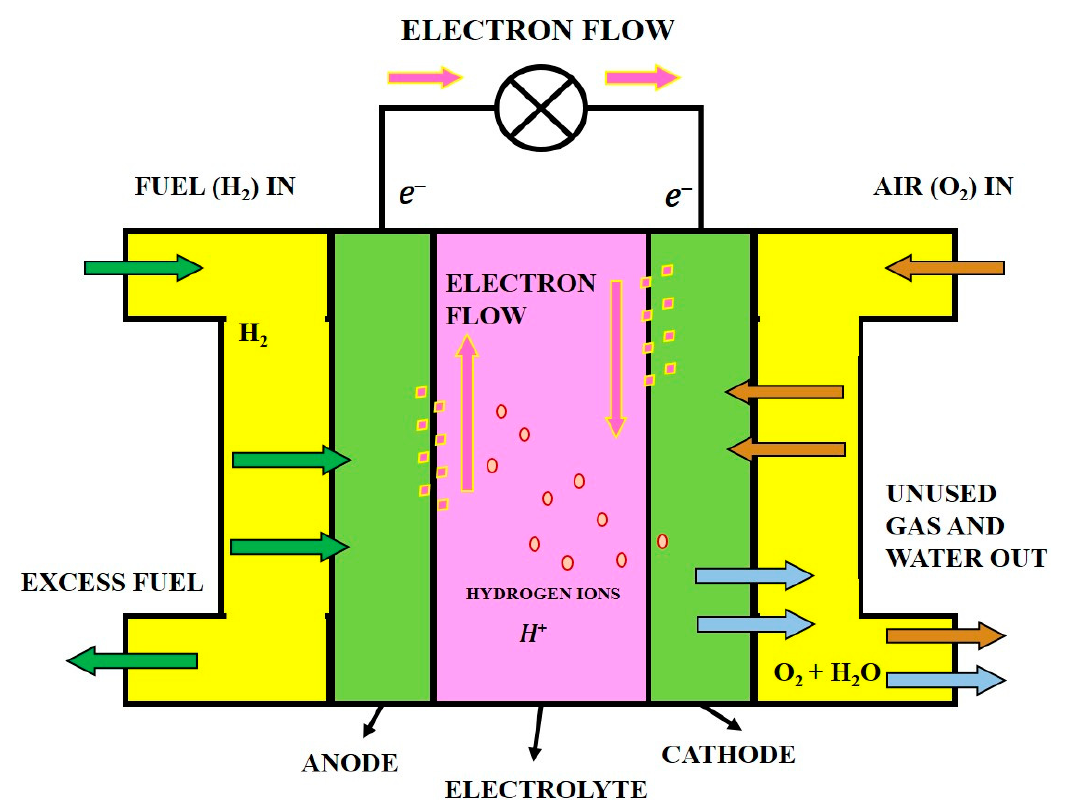
Figure 2. Schematic representation of the working nature of a PCFC.